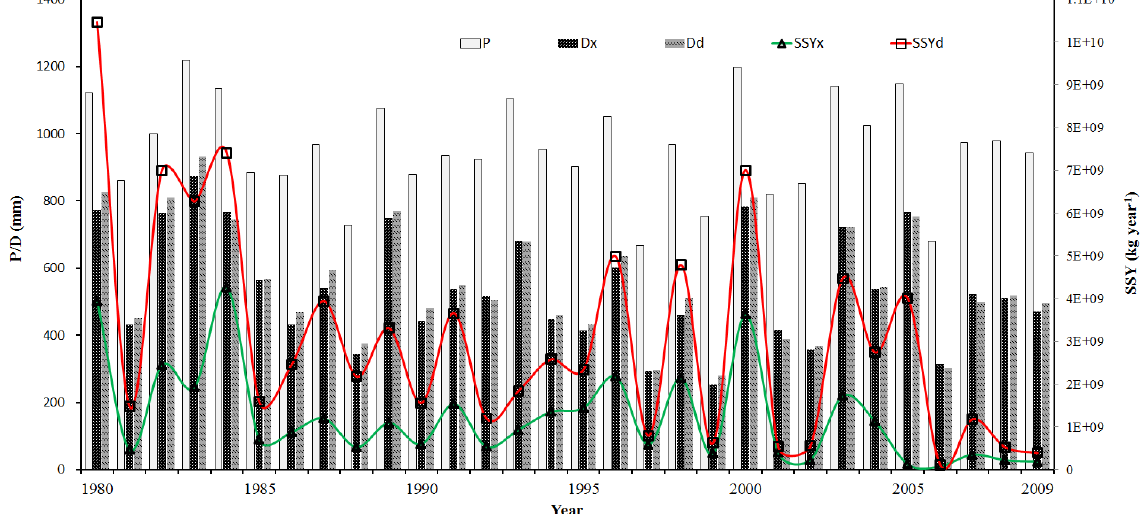
Figure 3. Annual P , D and SSY for the hydrological years of 1980–2009 from the Zhushan and Xinzhou gauges. Table 4. Monthly mean streamflow from the Xinzhou and Zhushan